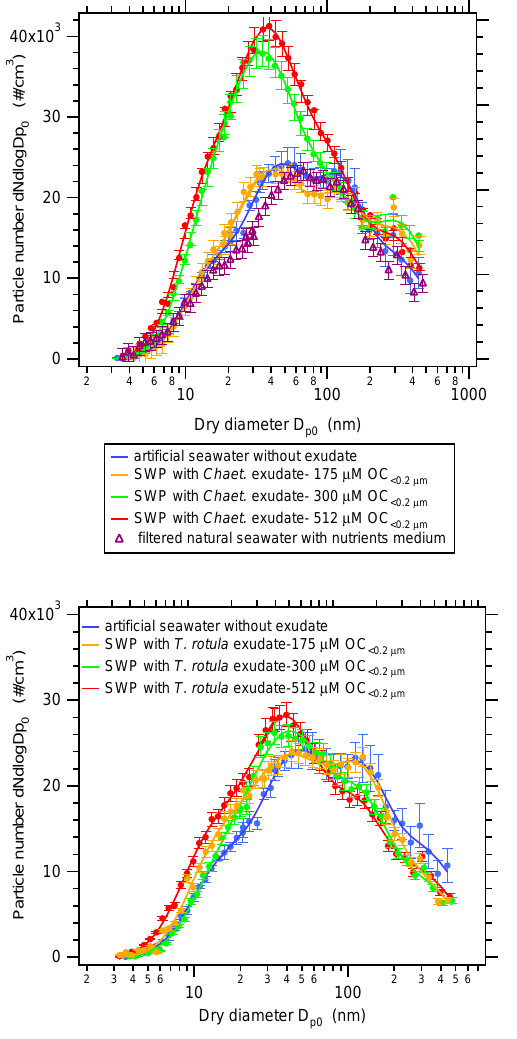
Fig. 9. Effect of organic exudate concentration on the total particle number N t (a, b, c) and geometric mean D p 0 g (d, e, f, g) of the four lognormal modes comprising the particle size distributions gener- ated from seawater enriched with Chaetoceros and T. rotula exu- dates (lognormal modal sizes ( Dp 0 ): mode 1, ∼ 12–15nm; mode 2, ∼ 37–46nm; mode 3, ∼ 115-127nm; mode 4, ∼ 315–328nm).